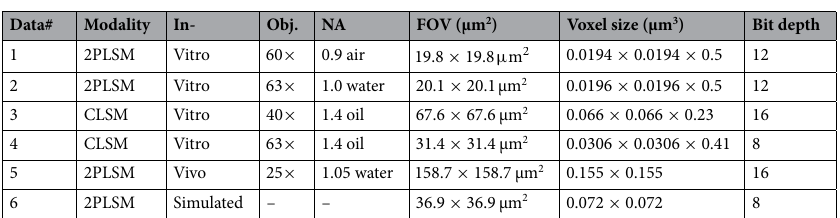
Table 1. Details of the datasets used in the study. The last column presents the median filter window size we used during the analysis that can be used as a guideline by the